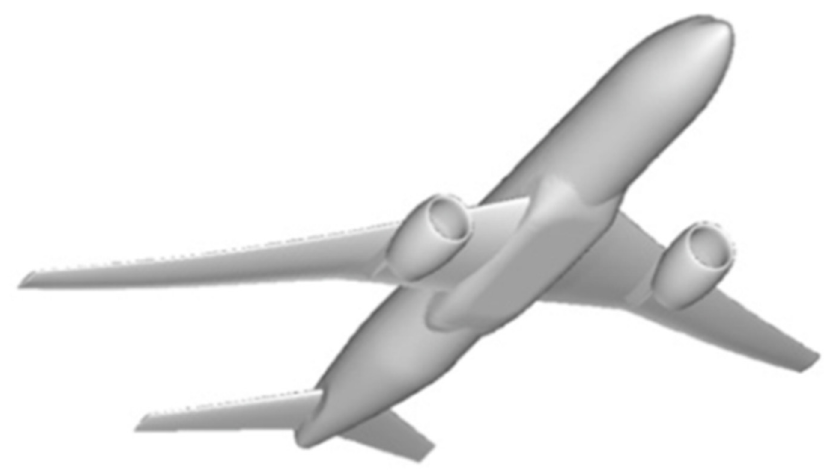
Figure 17. Common research model (CRM) reference configuration.